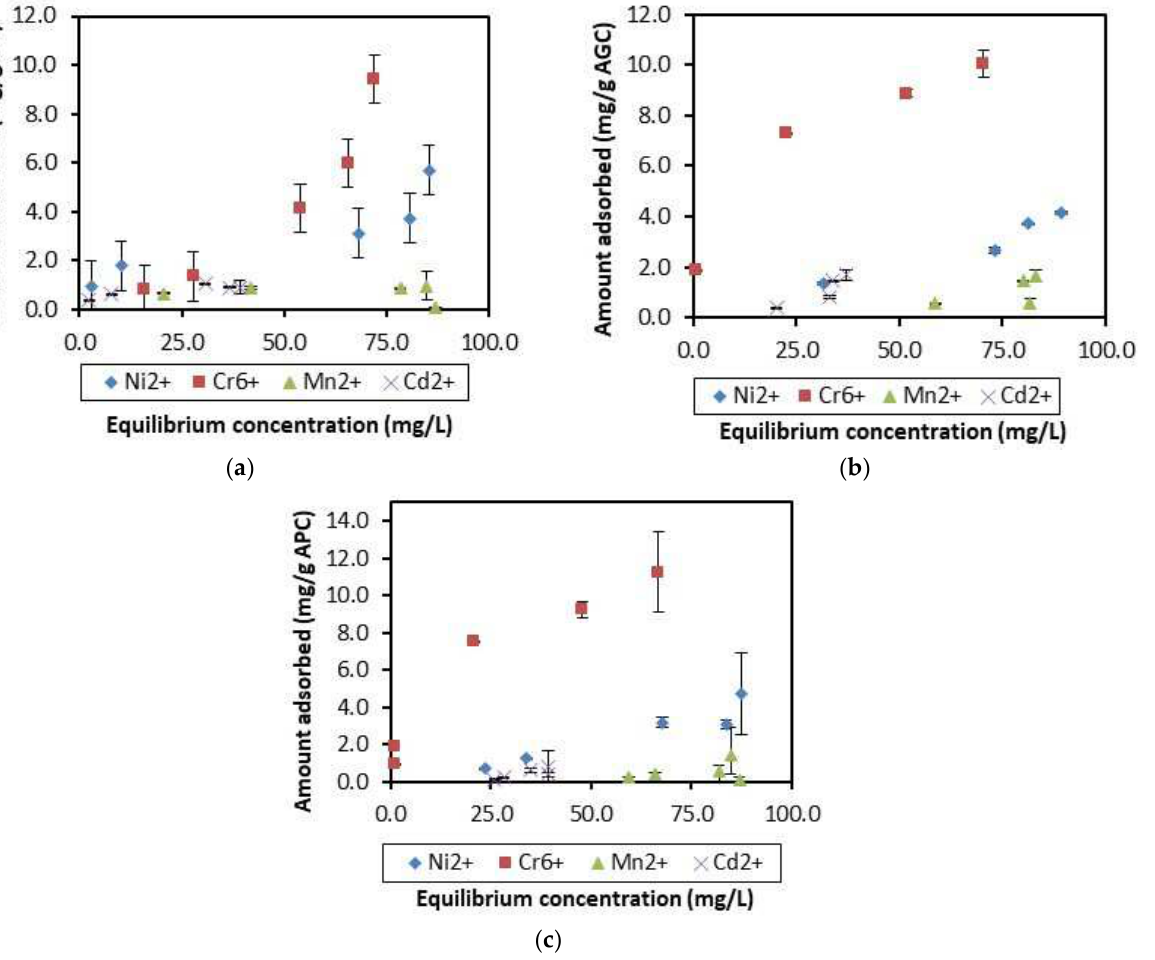
Figure 2. Adsorption isotherms of metal ions on different adsorbents: ( a ) AC, ( b ) AGC, and ( c ) APC.